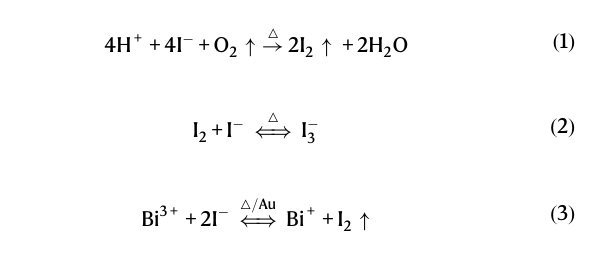
as-grown crystal with the stripped surface. d SEM image of an exfoliated fl ake transferred onto a conductive